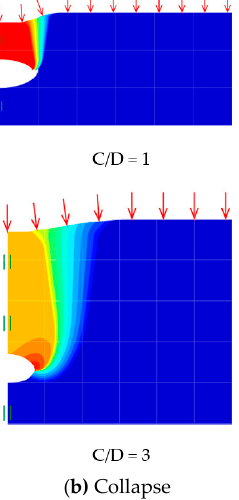
Figure 19. Absolute velocity (|u|) contour plot ( B/D =